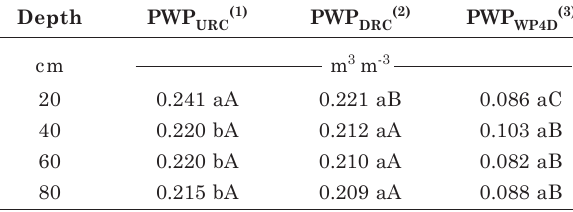
Table 2. Volumetric water content ( θθθθθ ) at the permanent wilting point (PWP) obtained by different estimation methods at 1500 kPa tension in a Richards chamber (CR) and thermocouple psychrometer (WP4) in samples with undisturbed structure (I) and with disturbed structure (D) Depth